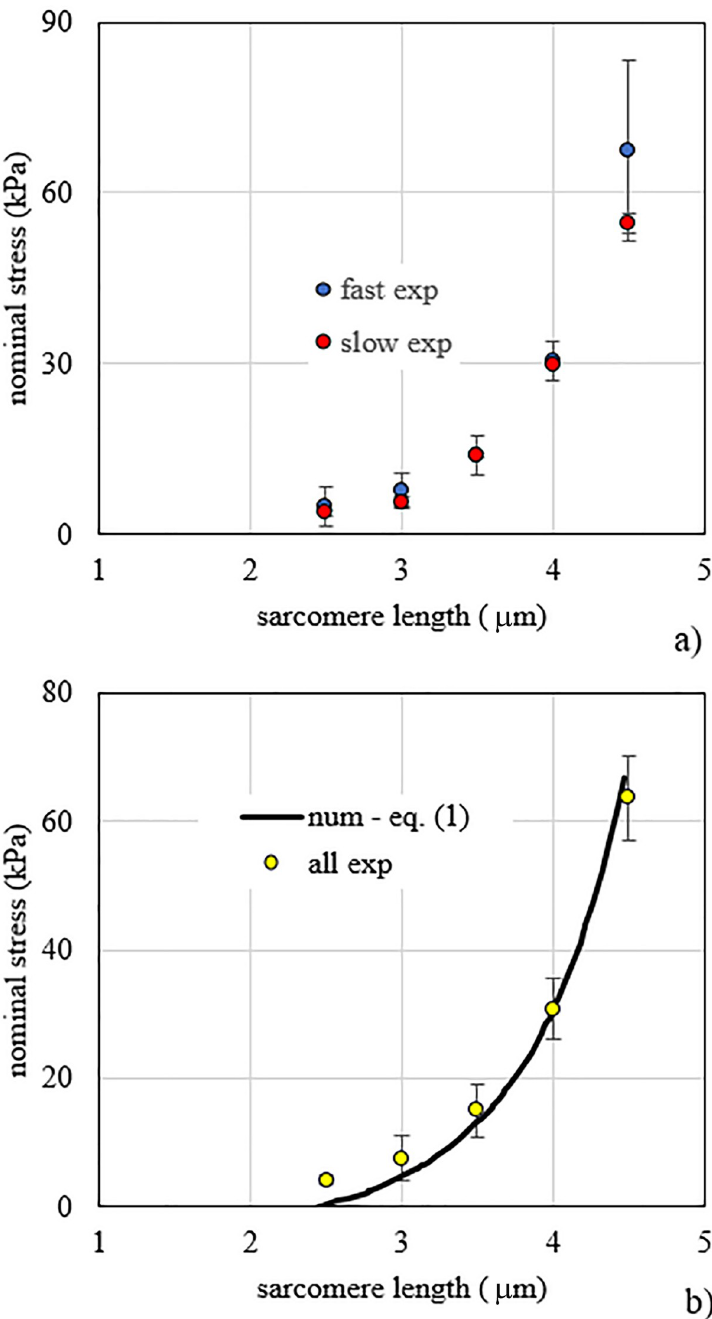
Fig 2. Fibre stress vs. sarcomere length. a) Stress vs. sarcomere length experimental data for passive elongation of fast and slow fibres. b) Stress vs. sarcomere length experimental data of pooled fast and slow fibres compared to numerical results obtained by the fitting of Eq (1) proposed in the present